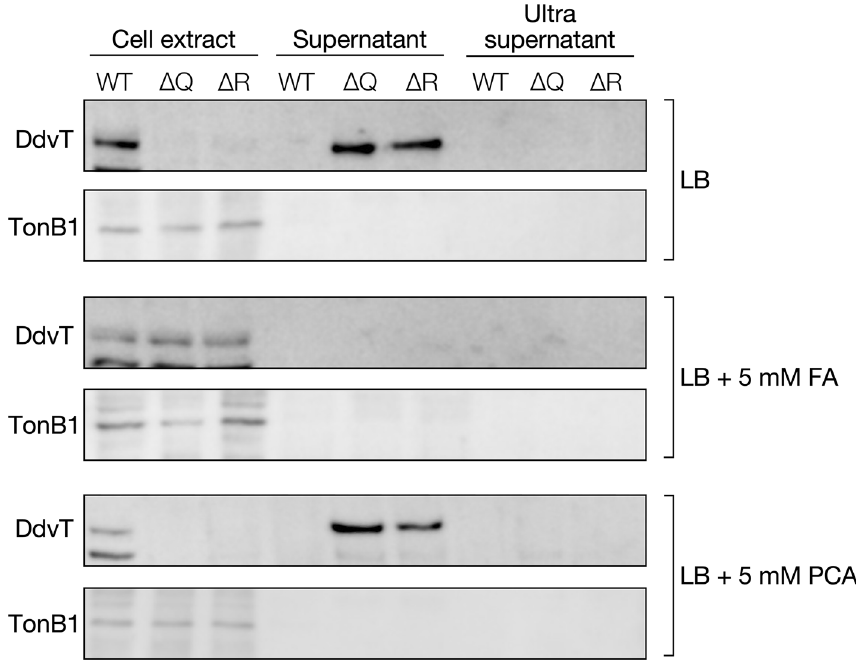
Figure 7. Detection of the outer membrane fraction in the culture supernatants of exbB2 / tolQ and exbD3 / tolR mutants. Cells of the wild type (WT), ∆ exbB2 / tolQ (∆Q), and ∆ exbD3 / tolR (∆R) were grown in LB with or without 5 mM FA or PCA. As shown in Fig. S13, after centrifugation, the supernatants of the cultures were collected (supernatant), and the cell extracts were prepared. The supernatants were further ultracentrifuged, and the resulting supernatants were collected (ultrasupernatant). Western blot analysis using anti-DdvT and anti- TonB1 antibodies was performed against cell extracts (10 µg of protein), 20 µl of the supernatant, and 20 µl of the ultrasupernatant. The uncropped blot images are shown in Fig. S16. This figure was generated using Canvas X Draw version 7.0.2. (https:// www. canva sgfx. com/ produ cts/ canvas- x-